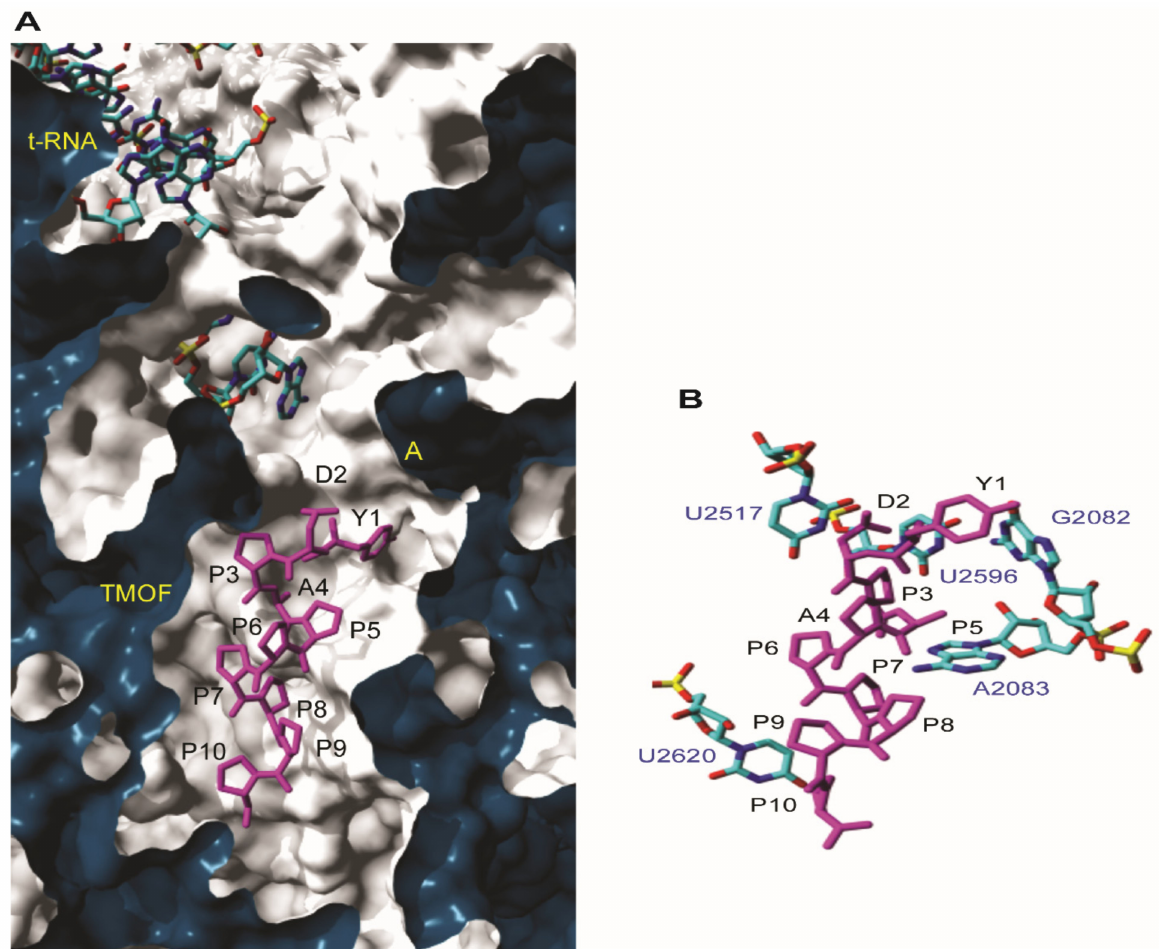
Figure 5. ( A ) Close-up cut view showing the docking of Aea TMOF (magenta stick) within the peptide exit tunnel of 23S RNA of T. thermophilus ribosome. The 5tRNA and the A-site of the 23S RNA are indicated. ( B ) Docking of Aea TMOF (magenta stick) into the peptide exit tunnel of 23S RNA of T. thermophilus showing the nucleotide bases (blue sticks) involved in the interaction with the peptide through hydrogen bonds (not shown) and stacking